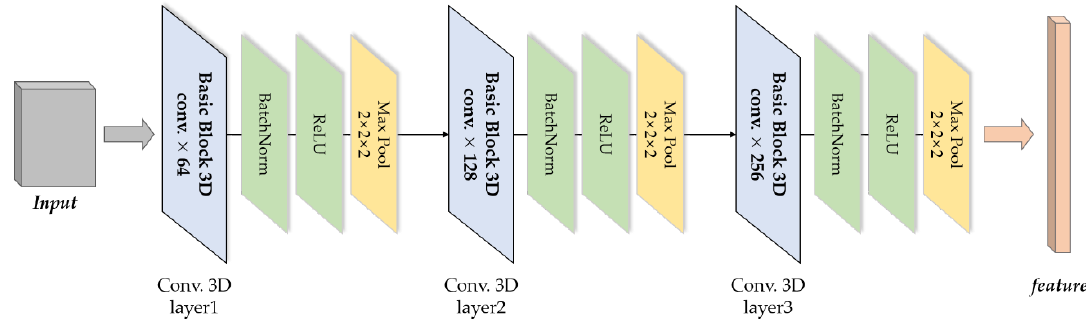
Figure 10. Architecture of a feature extractor based on 3D-CNN. Figure 11. The architecture of a basic block for 3D-CNN.